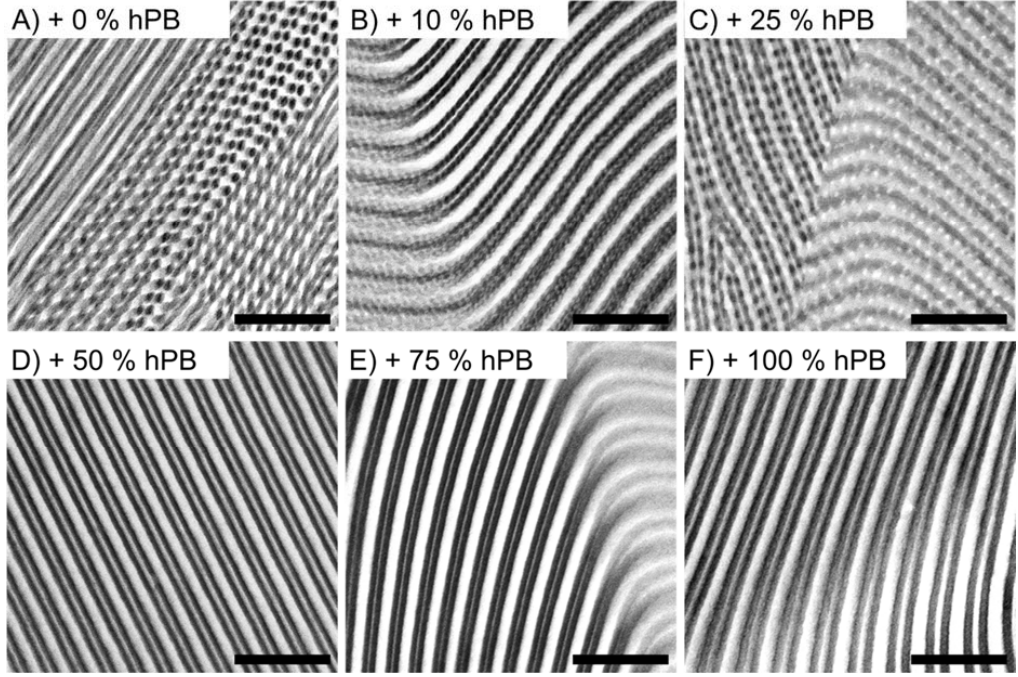
Figure 1. Transmission electron microscopy (TEM) images of bulk morphologies of SBM / B with varying weight fractions of added hPB. TEM images of resulting bulk film from 0% ( A ) to 100% ( F ) hPB in relation to PB domain in SBM. (All samples were stained with OsO 4 to enhance the contrast of PB, scale bars are 200 nm).